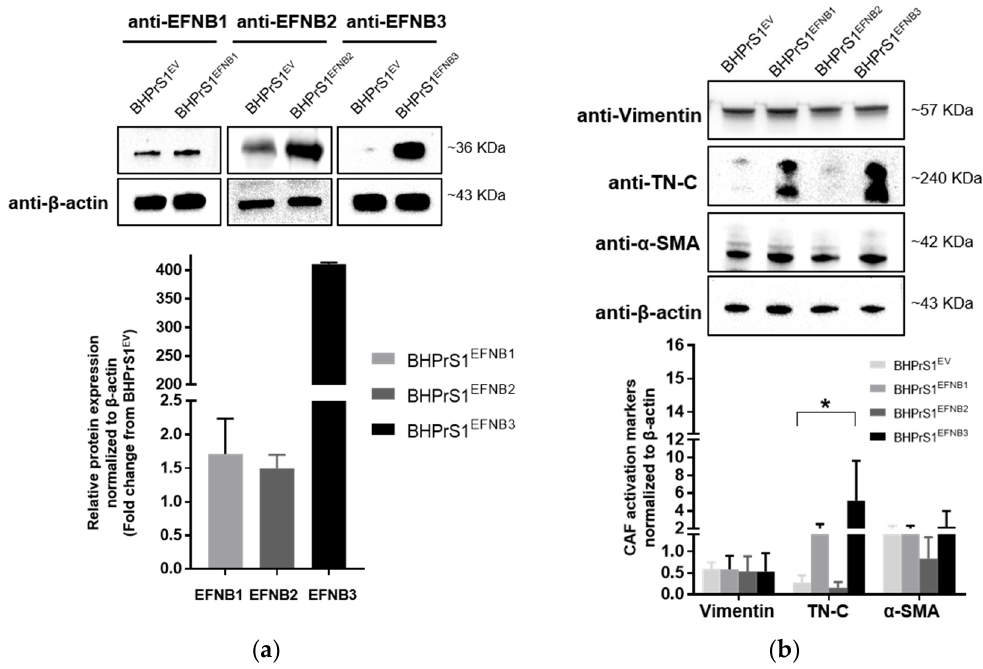
Figure 2. Overexpression of Ephrin B ligands in normal prostate fibroblasts induce the activation of cancer associated fibroblasts (CAF) markers. ( a ) Expression of EFNB1, EFNB2, and EFNB3 ligand proteins in lentivirus transduced BHPrS1 cells was validated by Western blot. The bands were quantified and normalized to β -actin and presented as fold change in protein expression compared to BHPrS1 EV ( n = 3 independent experiments). ( b ) The protein levels of Vimentin and putative CAF markers, Tenascin-C (TN-C), and alpha-smooth muscle actin ( α -SMA) were evaluated in Ephrin- generated cell lines (BHPrS1 EFNB1 , BHPrS1 EFNB2 , BHPrS1 EFNB3 ) by Western blot. The bands were quantified and normalized to β -actin and presented as the mean (* p < 0.05, one-way ANOVA, n = 3 independent